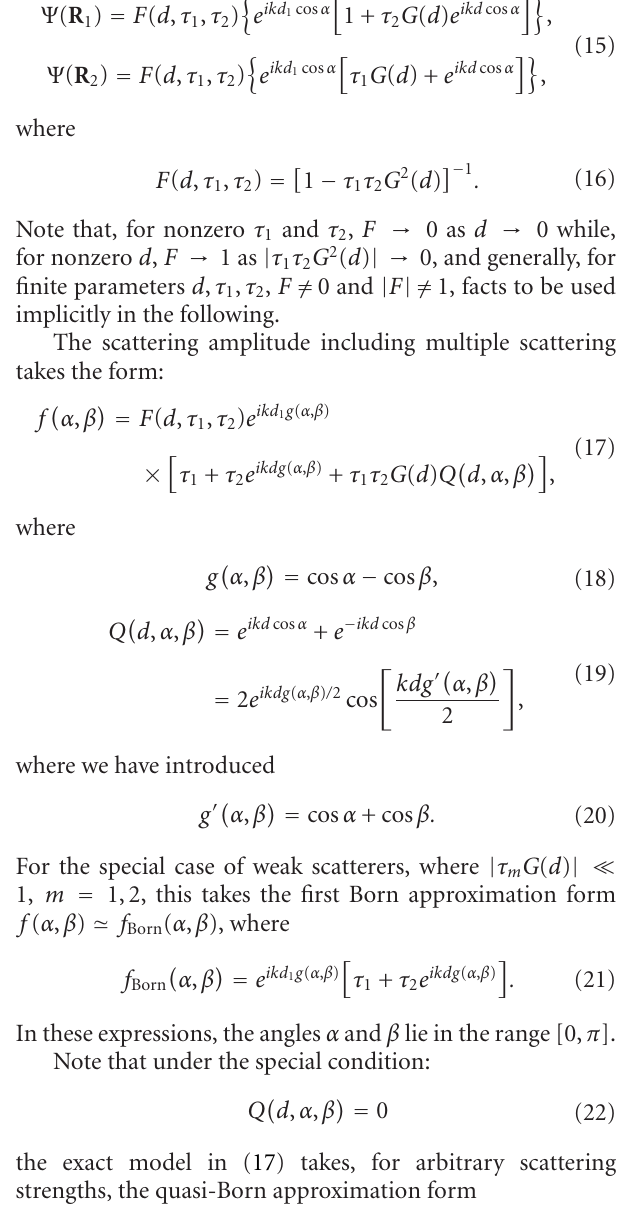
Figure 1: Conceptual illustration of the scattering